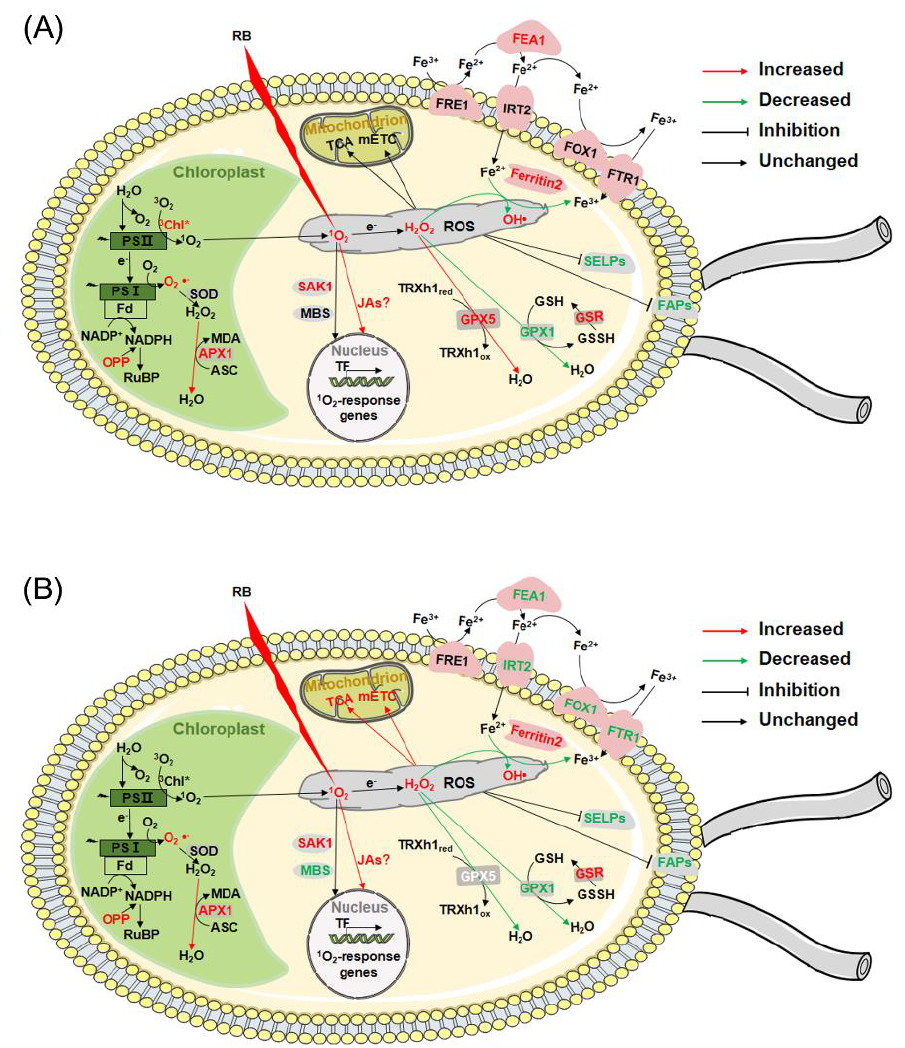
Figure 7. Summary of the cellular response to oxidative stress in CC4348 ( A ) and the gpx5 mutant ( B ). ( A ) After treatment with RB, the CC348 cells upregulated the ROS detoxification system and inhibited the expression of flagellar associated proteins (FAPs) and selenoproteins (SELPs). ( B ) When the gpx5 mutant su ff ered the treatment with RB, expect for the same responses of ROS detoxification system, FAPs and SELPs, several specific responses occurred, such as accelerated the TCA cycle and mETC in mitochondria, repressed genes related to chlorophyll metabolism and photosynthesis, and downregulated iron transporters. Red characters indicate upregulated expression of related proteins or metabolic pathways after RB treatment, while green characters indicate downregulated expression of related proteins or metabolic pathways after RB treatment. Abbreviations: APX, ascorbate peroxidase; ASC, ascorbate; FAPs, flagellar associated proteins; Fd, ferredoxin; FEA1, Fe-assimilating protein 1; FOX1, ferroxidase; FRE, ferrireductase 1; FTR1, ferric ion transporter 1; GPX, glutathione peroxidase; GSR, glutathione reductase; GSH, glutathione; GSSG, oxidized glutathione; IRT2, ferrous ion transporter 2; mETC, mitochondrial electron transfer chain; OPPP, oxidative pentose phosphate pathway; ROS, reactive oxygen species; PRX, peroxiredoxin; PSI / II, photosystem I / II; RB, rose bengal; RuBP, ribulose 1,5-bisphosphate; SELPs, selenoproteins; SOD, superoxide dismutase; TF, transcription factor; TRXh1, thioredoxin h1. SAK1 [17] and MBS [16] are two cytosolic proteins required for induction of nuclear gene expression responses by 1 O 2 .